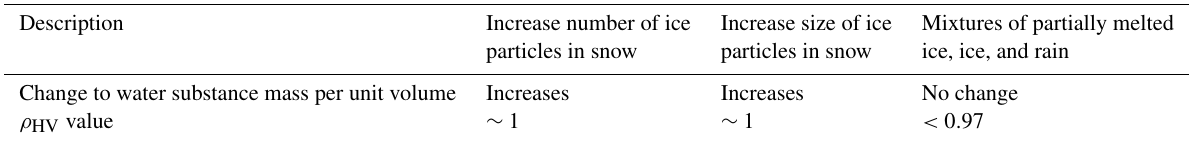
Table 1. Correlation coefficient values associated with physical mechanisms that increase radar reflectivities when Z > 20dBZ and other conditions are held